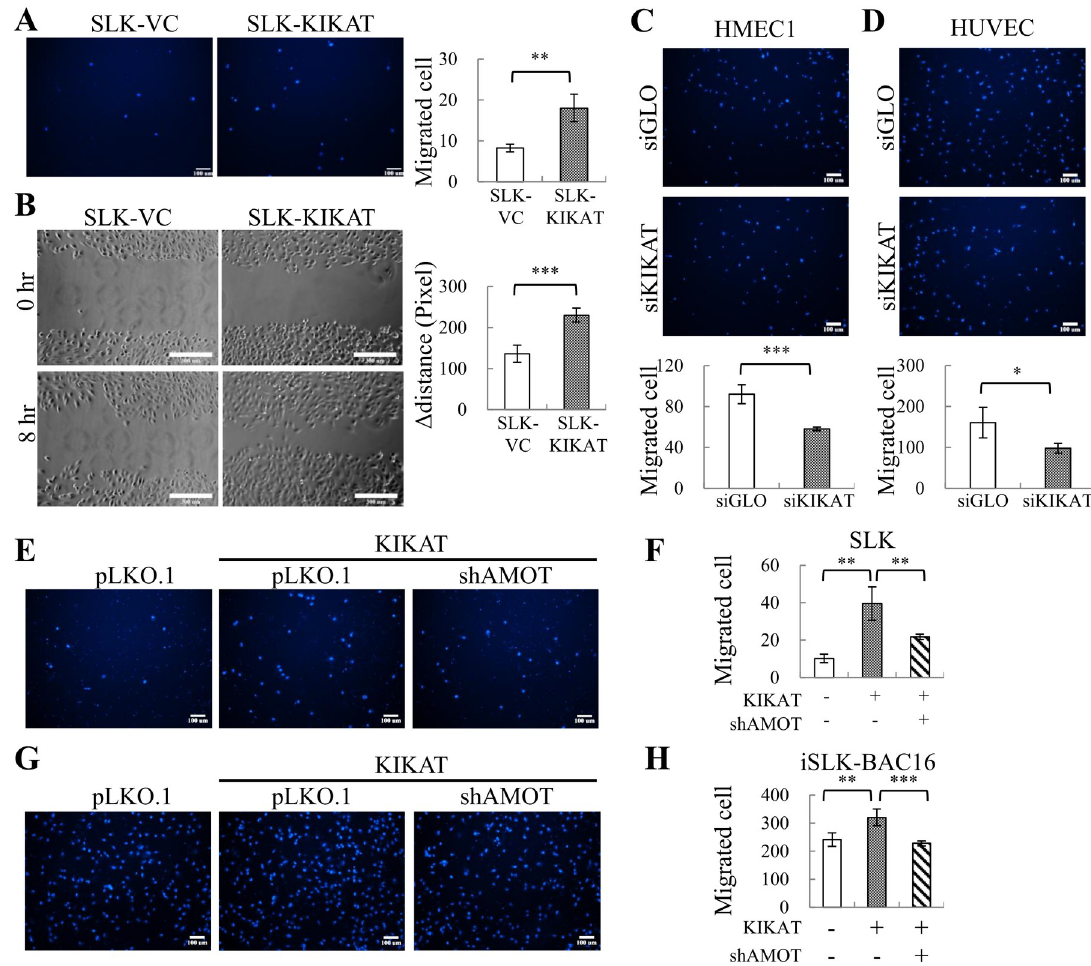
Fig 6. KIKAT/LINC01061 enhances SLK migration in an AMOT-dependent manner. (A) Representative images (100x magnification) of in vitro transwell migration analysis of SLK-KIKAT/LINC01061 and SLK-VC cells at 6 hours (left). Scale bar: 100 μ m. Quantification of cell migration (right). (B) Representative images (100x magnification) of in vitro wound healing migration assay of SLK-KIKAT/LINC01061 and SLK-VC cells at 8 hours (left panel). Scale bar: 300 μ m. Quantification of wound healing (right panel). (C and D) Representative images (100x magnification) of migration analysis of HMEC1 (C) and HUVEC (D) cells transfected with siKIKAT/LINC01061 or with control siGLO. (upper panel). Scale bar: 100 μ m. Quantification of cell migration (bottom panel). (E) Representative images (100x magnification) of migration analysis of KIKAT/LINC01061-transduced SLK cells with or without transduction of lentivirus expressing shAMOT. Scale bar: 100 μ m. (F) Quantification of cell migration in (E). (G) Representative images (100x magnification) of migration analysis of KIKAT/LINC01061-transduced iSLK-BAC16 cells with or without transduction of lentivirus expressing shAMOT. Scale bar: 100 μ m. (H) Quantification of cell migration in (G). Scale bar: 100 μ m. Significance was determined by student’s t -test. � p < 0.05, �� p < 0.01, ��� p <